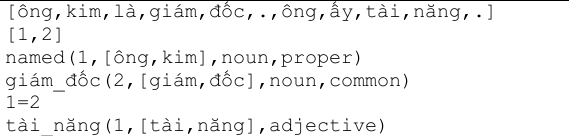
Figure 20. The DRS with main predicates of two- sentences Vietnamese paragraph “David hạnh phúc.